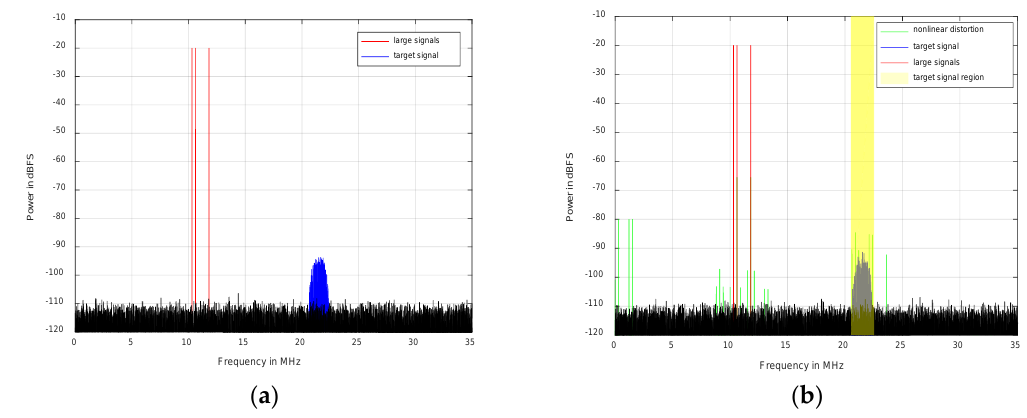
Figure 6. Classic simulation results of a distorted spectrum: ( a ) original signal; ( b ) distorted signal.